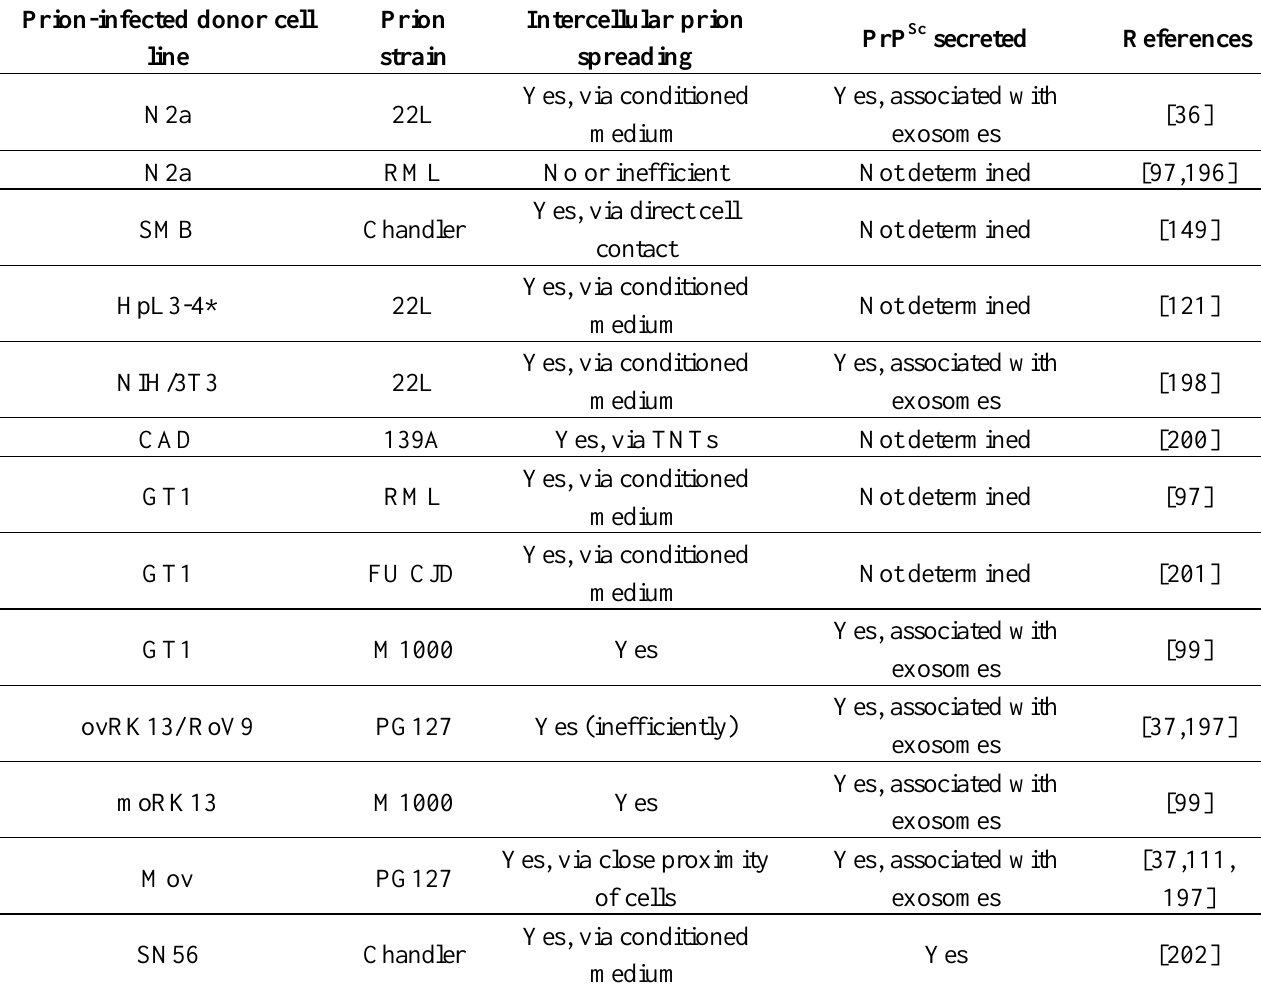
Table 2. Routes of prion dissemination in cell